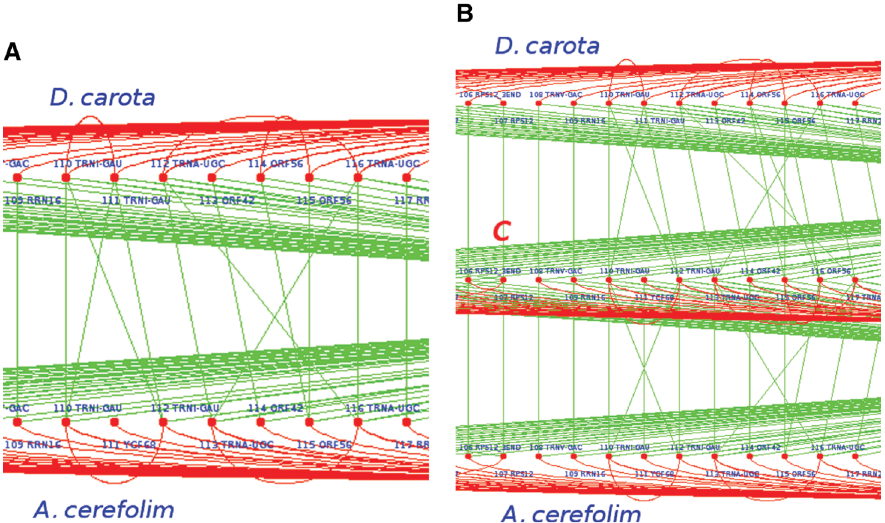
Figure 6: Green lines indicate homologuous genes while red vertices are for paraloguous ones. C line in figure (B) is the reconstructed ancestor of these two